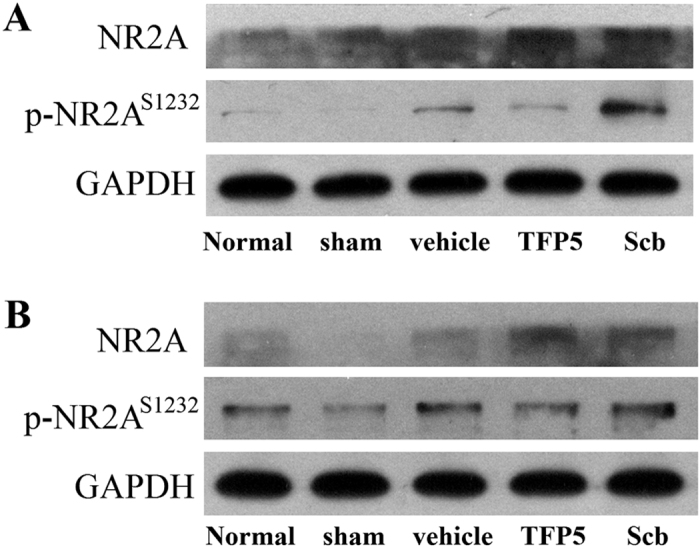
A dose of 30 mg/kg of TFP5 reduced p-NR2AS1232 levels both in cortex neighbouring ischemic regions (A) and hippocampus of ischemic hemisphere (B) at 48 h after 2 h ischemia. The levels of NR2A and p-NR2AS1232 in animals with ischemic stroke were higher than normal and sham animals. However, among three ischemic groups, the p-NR2AS1232 levels in TFP5 group were lower than vehicle and Scb groups. Data was from four independent experiments. p-NR2AS1232, phosphorylated N-methyl-D-aspartate receptor subunit 2A at Ser1232; GAPDH, glyceraldehyde-3-phosphate dehydrogenase.